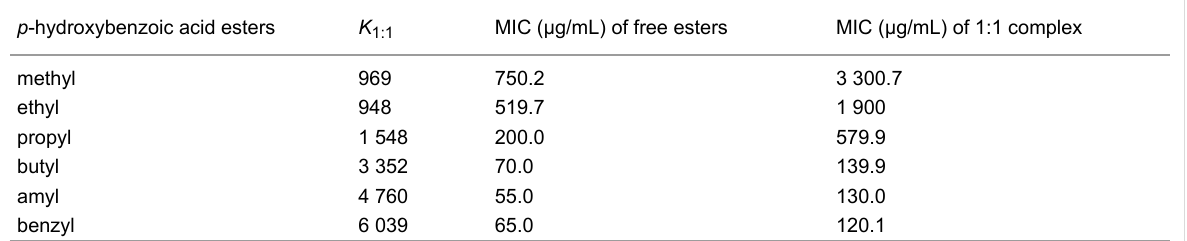
Table 3: Binding constants of HP- β -CD inclusion complexes with various p -hydroxybenzoic acid esters and minimal inhibition concentrations (MIC) for free and complexed p -hydroxybenzoic acid esters against C. albicans . a p -hydroxybenzoic acid